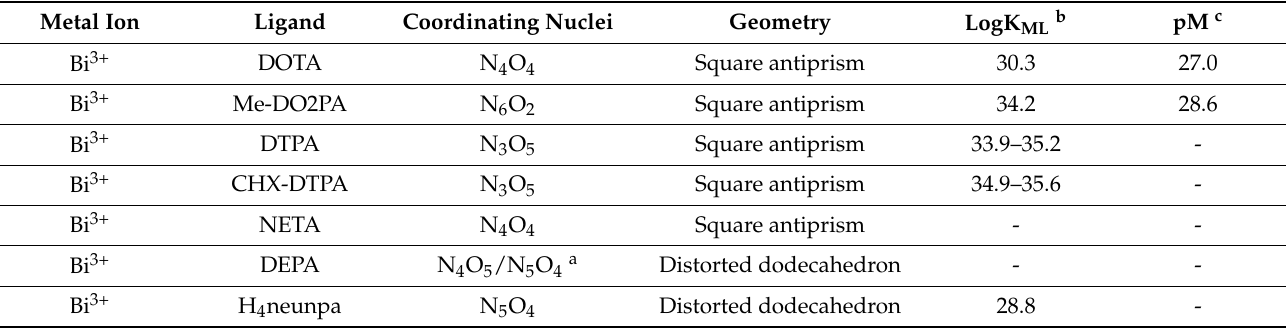
Table 2. Overview of Bi 3+ Chelators, Complex Geometry, and Thermodynamic Parameters. Table was adapted from Kostelnik et al., 2019, with permission from [2], American Chemical Society,